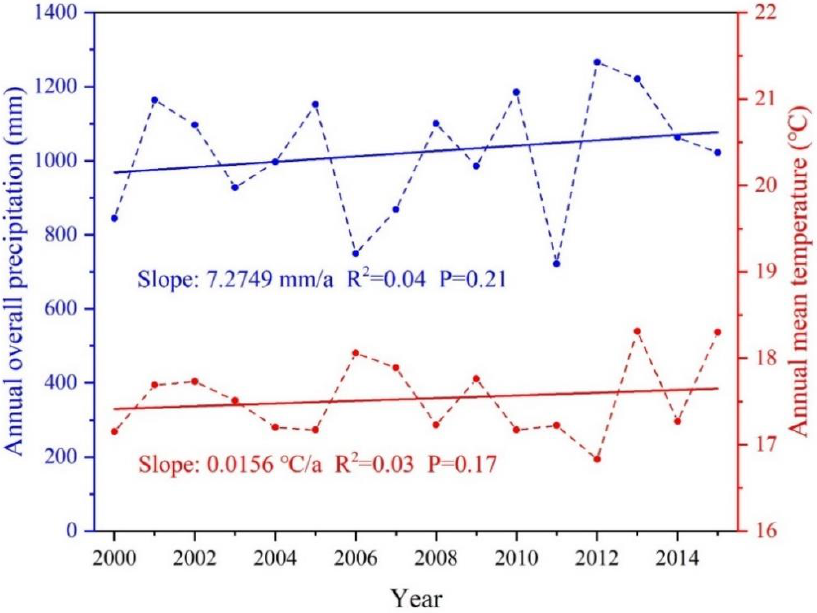
Figure 9. Annual average temperature and overall precipitation and their trendlines in Rong County during 2000–2015 (source: [32] ).